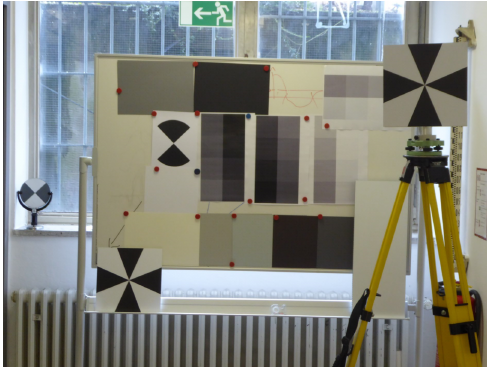
Figure 3. Data collection with targets of different gray